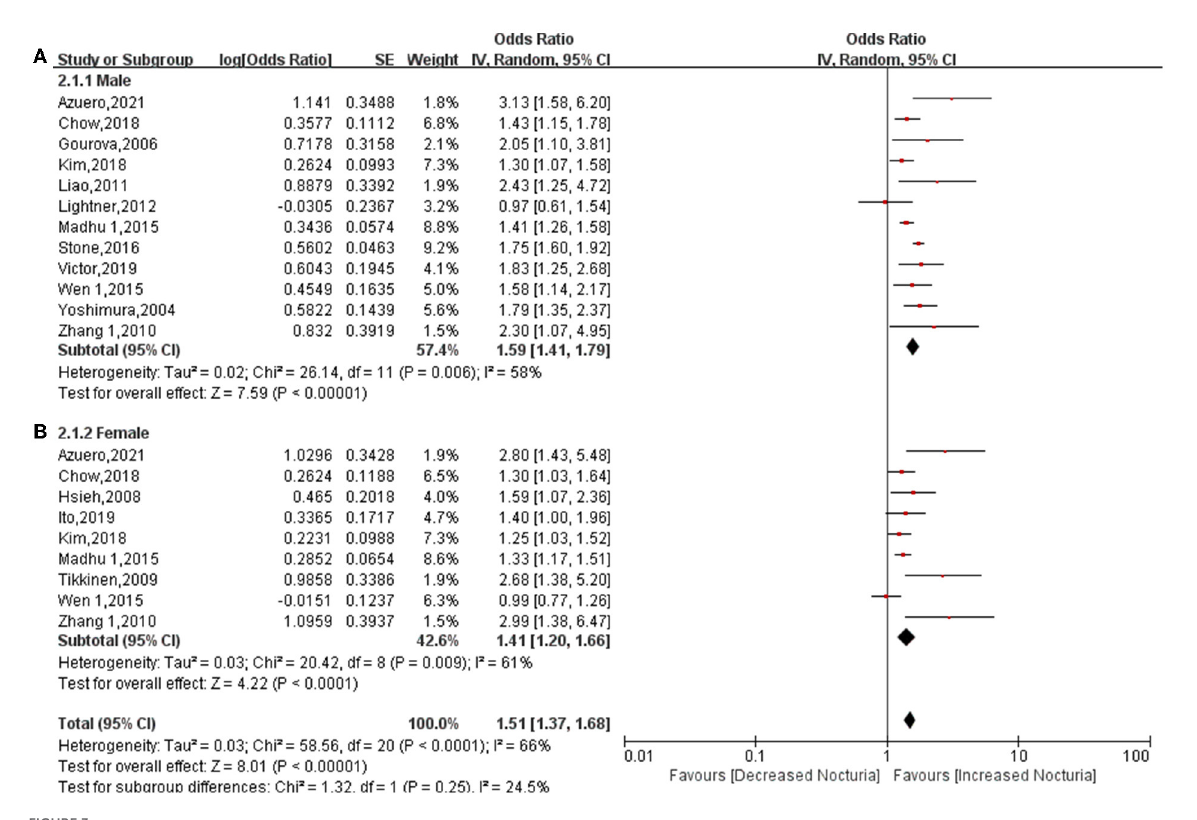
FIGURE3 Forest plot for the association between diabetes and nocturia stratified by gender. Men (A) , Women (B) .